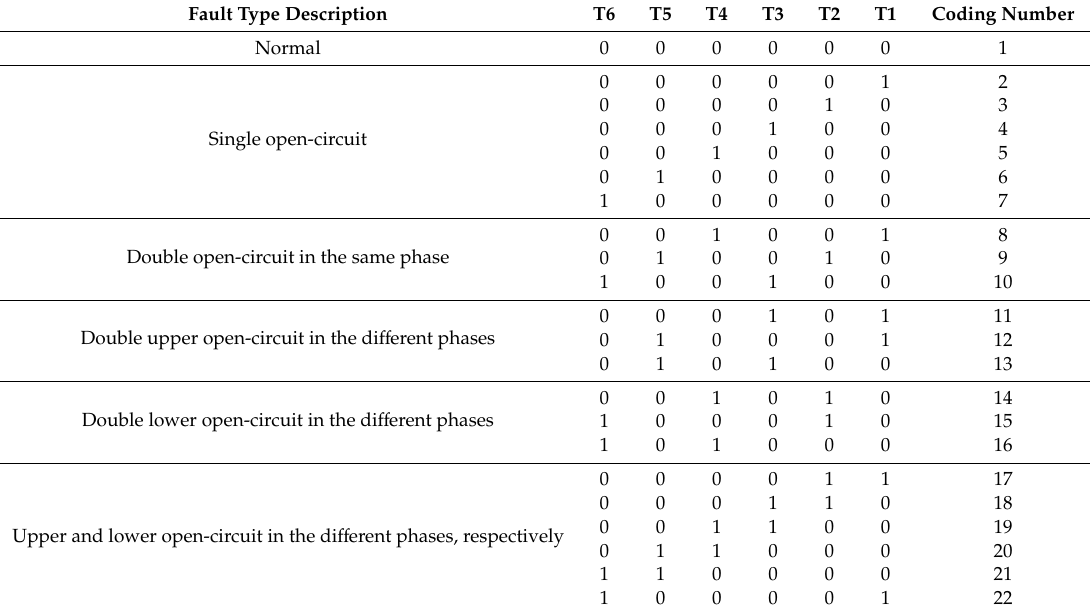
Table 1. Code of open-circuit fault of insulated gate bipolar transistor (IGBT)